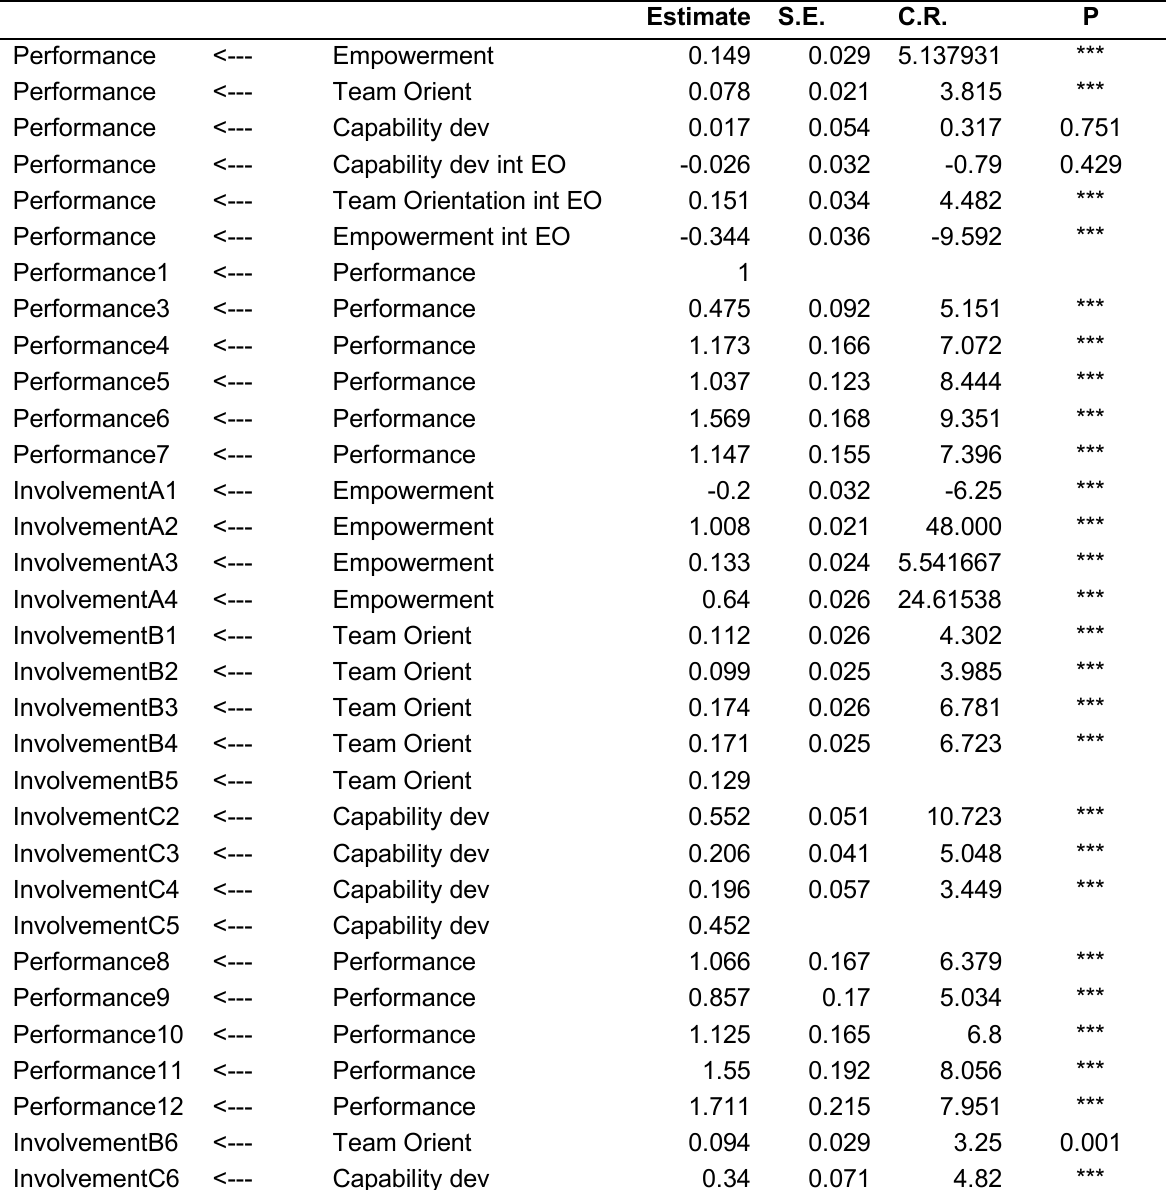
Table 5: Path coefficients for the structural model on the moderating effect of Entrepreneurial Orientation